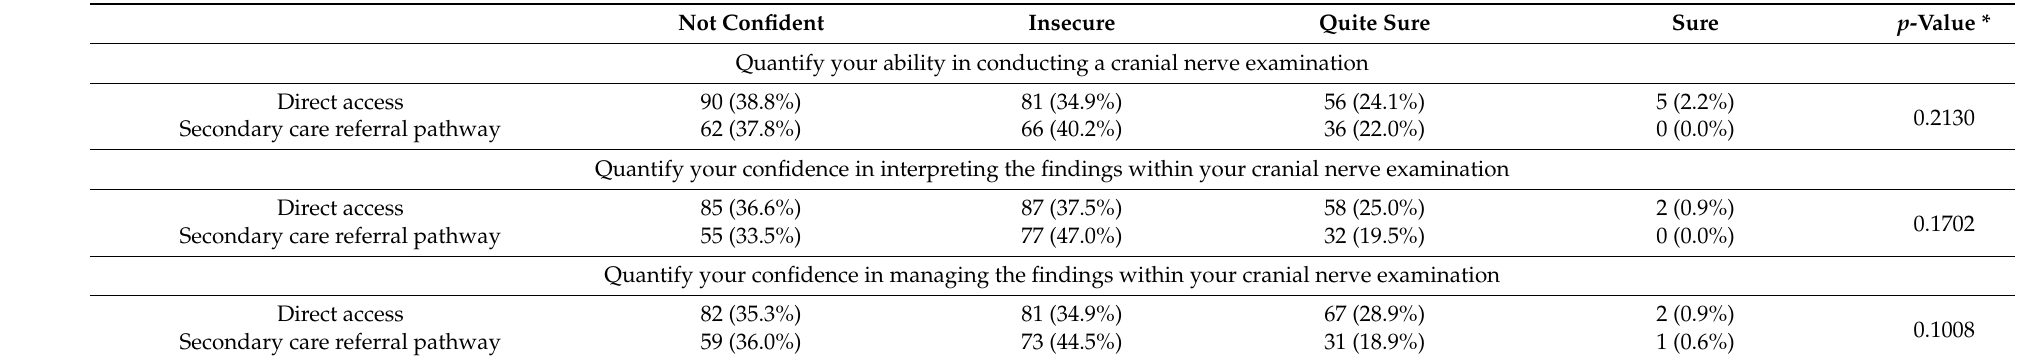
Table 5. Response to each survey questions, summarized for physiotherapy access